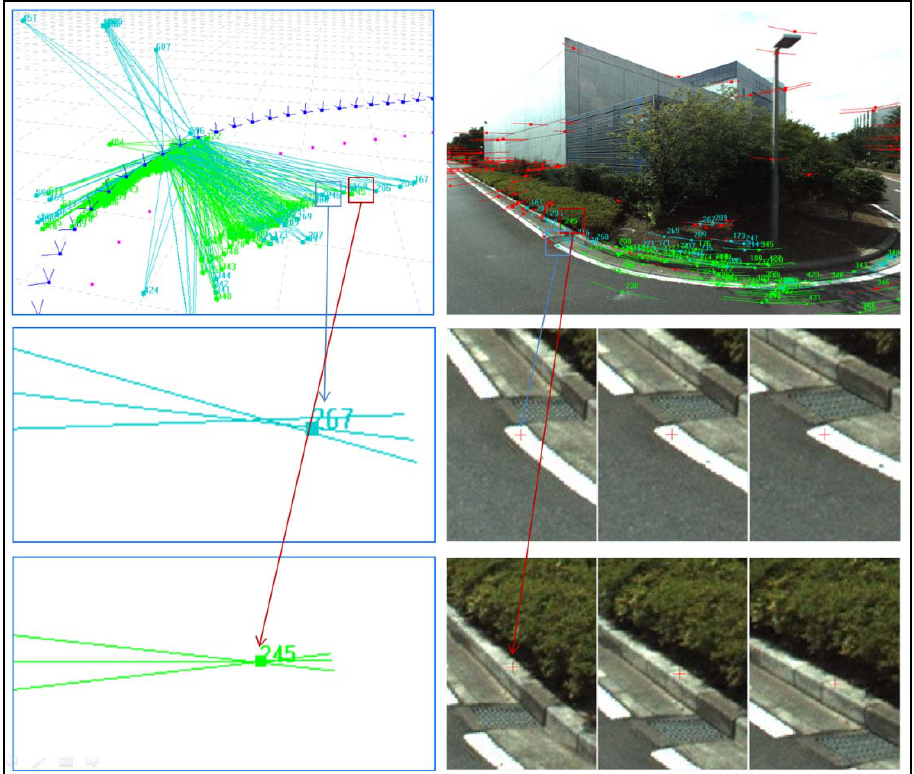
Figure 4. A 3D view of successfully matched tie-points (green). The points excluded by RANSAC (the first outlier elimination step) and histogram voting (the second step) are shown in red, and those excluded by BA (the third step) are shown in blue. The blue rays represent features that cannot intersect precisely, such as feature 267. Feature 267 may be regarded as correctly matched (right-middle images), but the lack of information about features in the window may introduce a bias of one or more pixels, which causes a slight intersection error (left-middle image). In contrast, feature 245 has a better texture and intersects